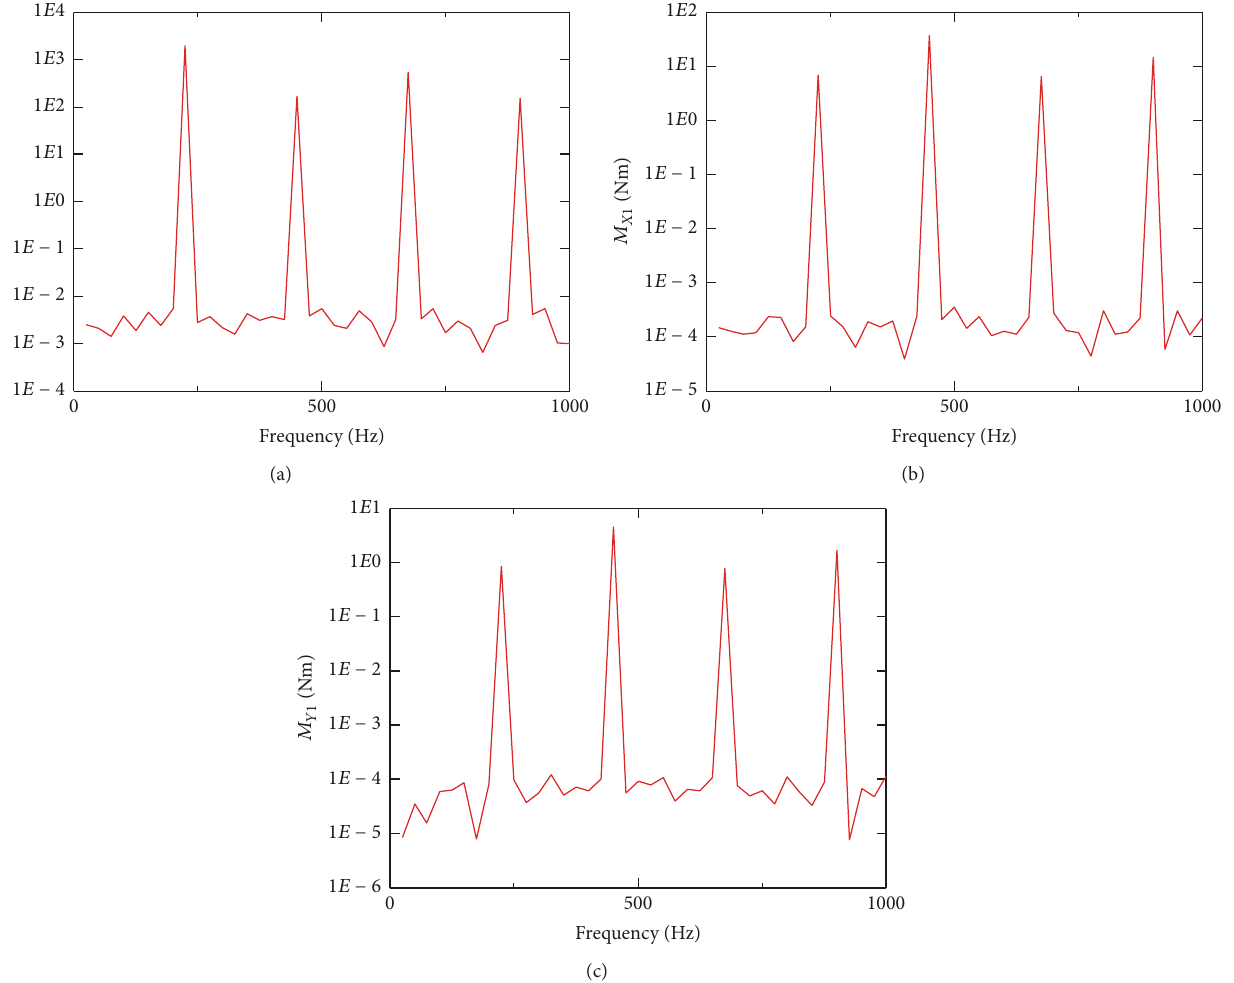
Figure 7: Variations of 𝐹 𝑍1 , 𝑀 𝑋1 , and 𝑀 𝑌1 in frequency domain.